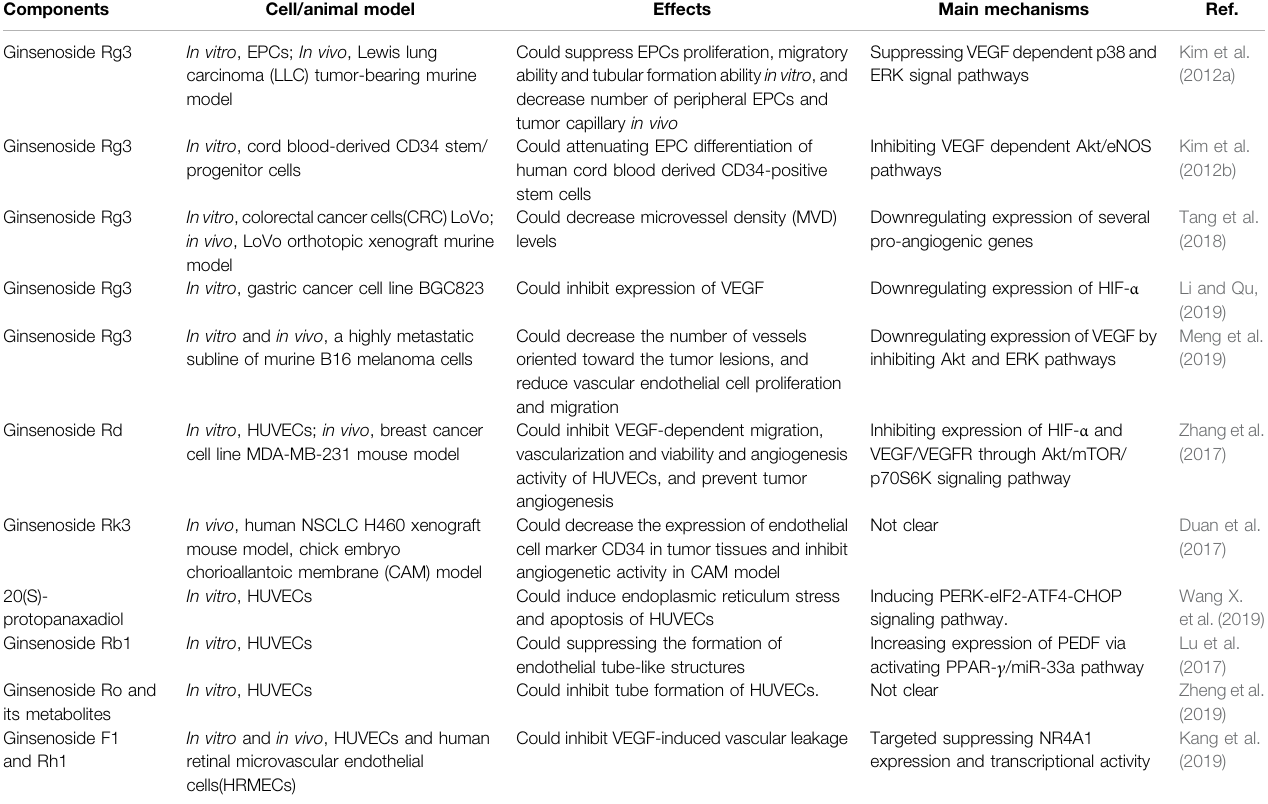
TABLE 1 | Effects of Ginsenosides on